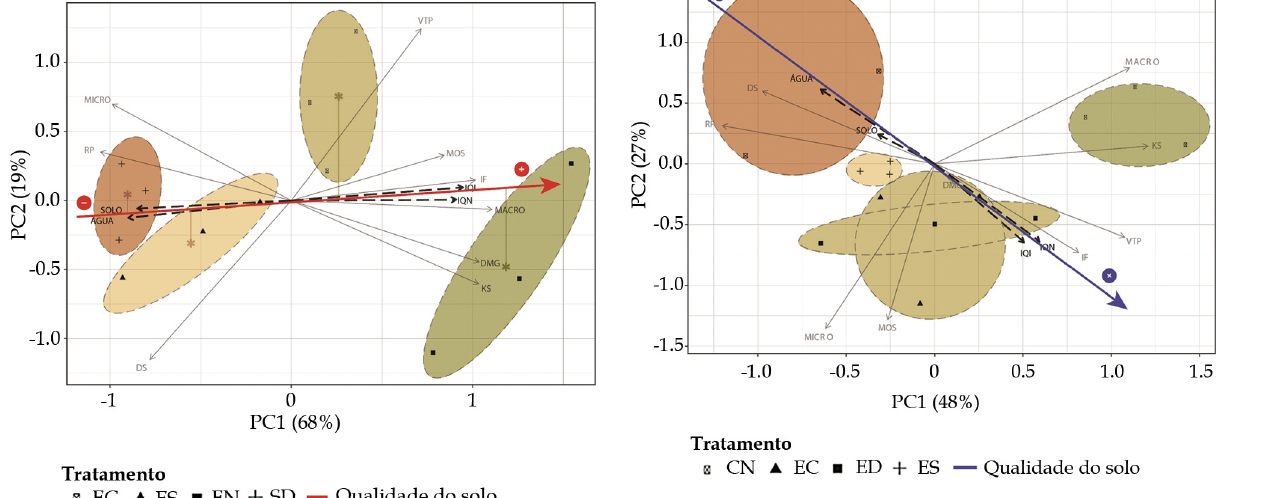
Figura 4. Análise dos componentes principais para os atributos físicos e matéria orgânica do solo (MOS) na classe de solo LVd1. Plantio em nível com resíduo (EC); plantio em nível sem resíduo (ES); floresta nativa (FN); solo descoberto (SD); microporosidade (MICRO); macroporosidade do solo (MACRO); resistência do solo à penetração (RP); densidade do solo (DS); volume total de poros (VTP); índice de floculação (IF); diâmetro médio geométrico de agregados do solo (DMG); permeabilidade do solo a água (KS); perda de solo (SOLO); perda de água (ÁGUA); índice de qualidade integrado (IQI); índice de qualidade Nemoro (IQN); componente principal 1 (PC1); e componente principal 2 (PC2).